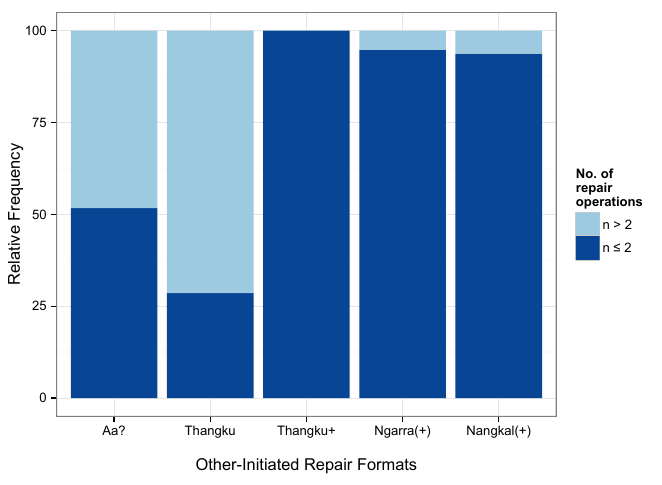
Figure 4: Relative frequency of OIR formats soliciting up to two – or more than two –repair operations. 18 One should be cautious about interpreting the inclination of this group. Thangku + covers a range of specialized restricted formats that just happen to be built out of thangku derived interrogatives. It is essentially a mixed bag of low frequency formats which may, individually, be more specialized than the grouped bar plot